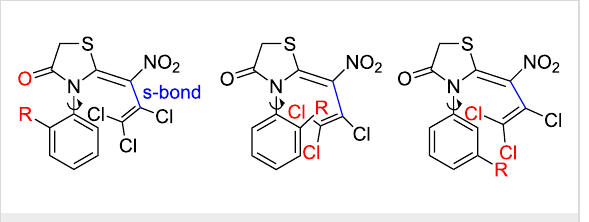
Figure 1: Hindered rotation in the case of ortho - or meta -substituted aniline precursors.